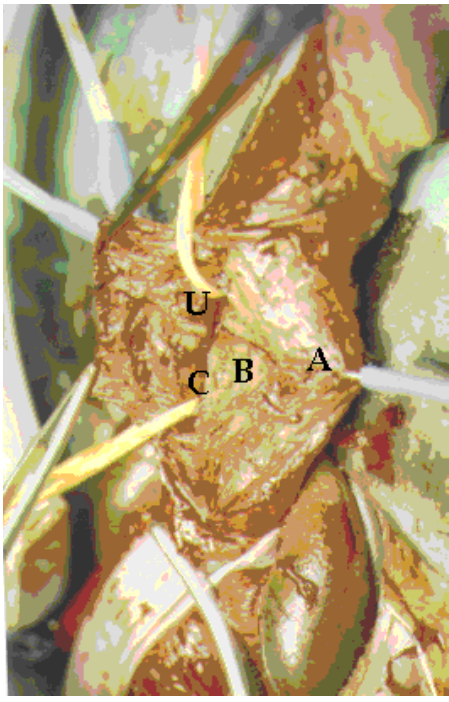
FIGURE 6 . Operating field and Scottís retractor. In this picture are clearly visible: the albuginea (A) which is retracted laterally by means of an hook; the site of corporeal rupture (B); the urethra (U) and its site of rupture where the catether (C) is